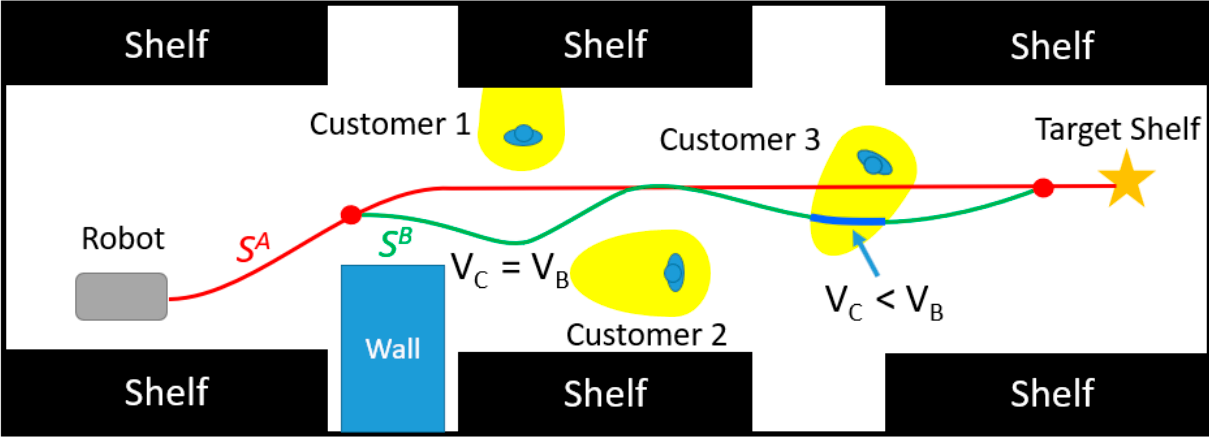
Figure 3. Combining A* algorithm and DWA-PS to plan a path to reach a given shelf.